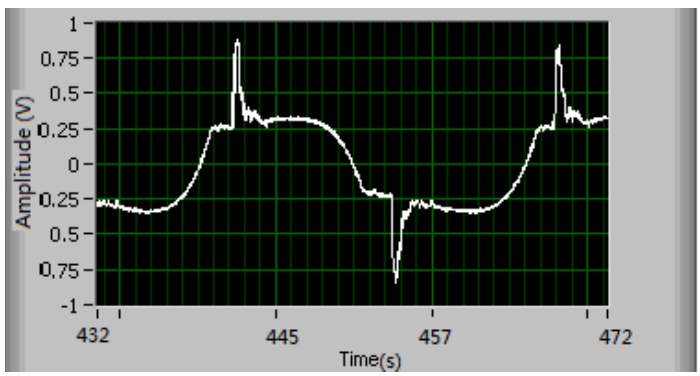
Figure 12. Control